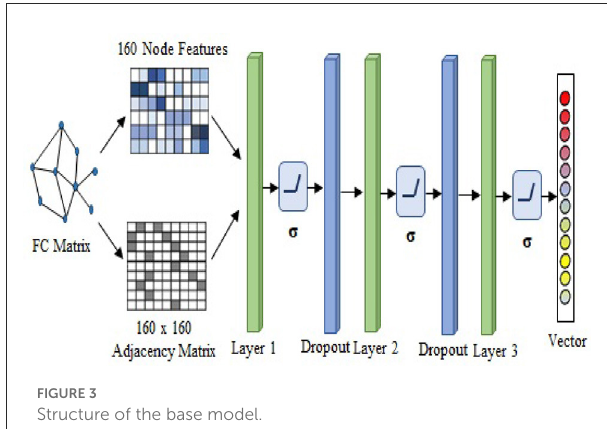
FIGURE3 Structure of the base model.